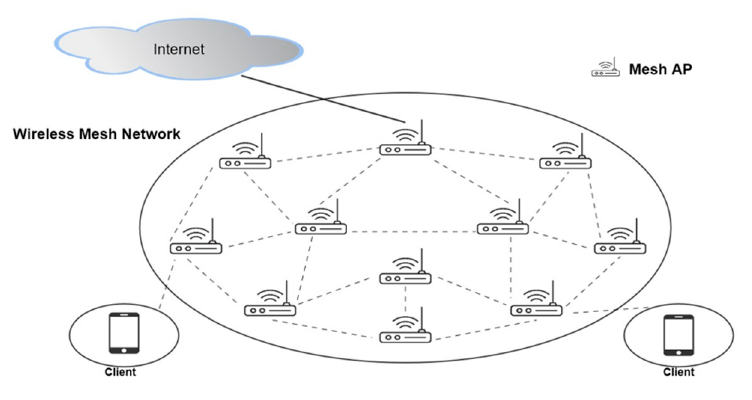
Figure 1. Wireless mesh network